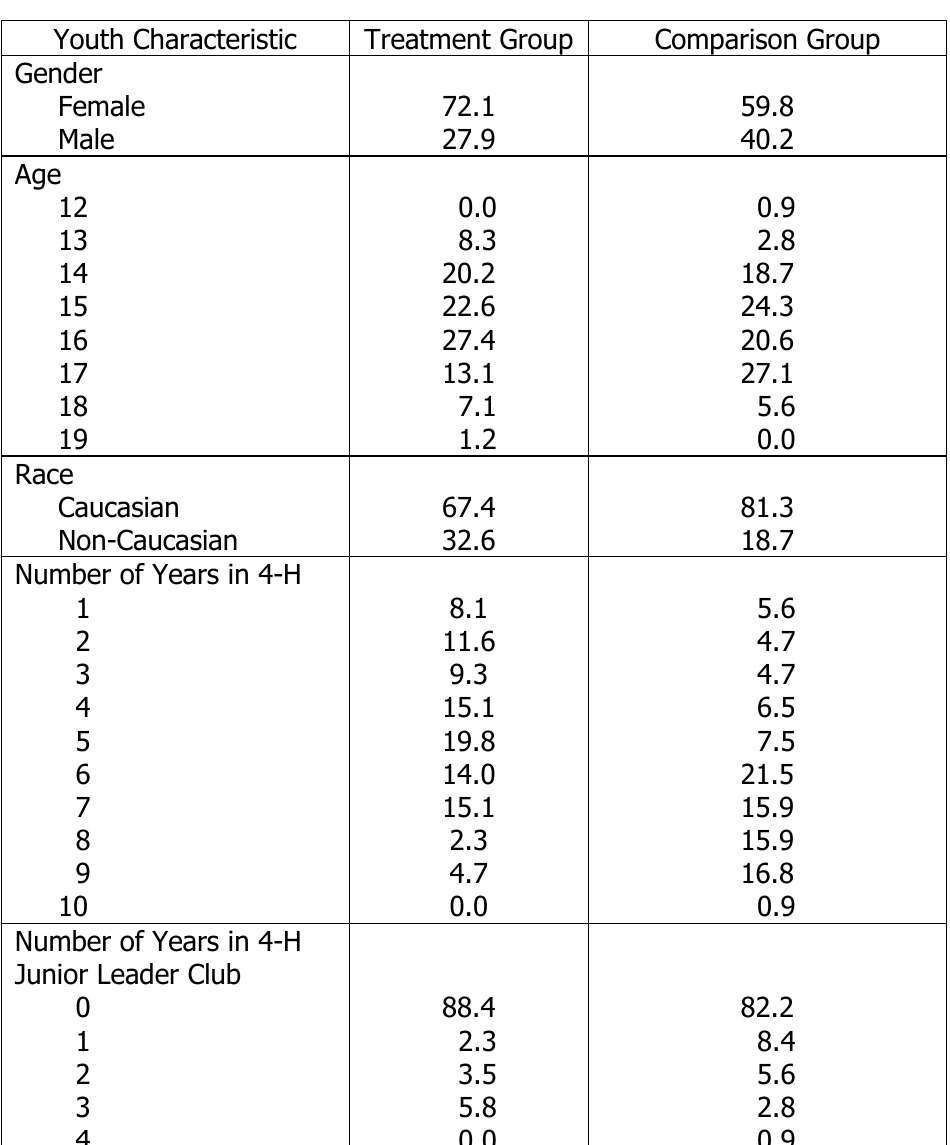
Demographic Characteristics of Youth Participants (N = 193), In Percents